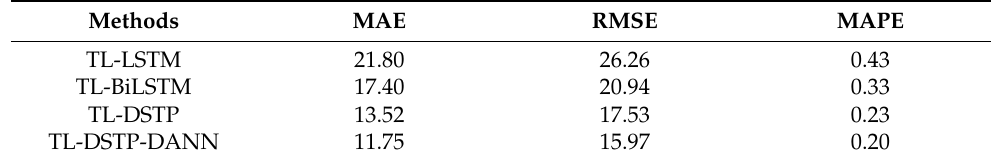
Table 2. Results of comparison between the proposed method and baselines.